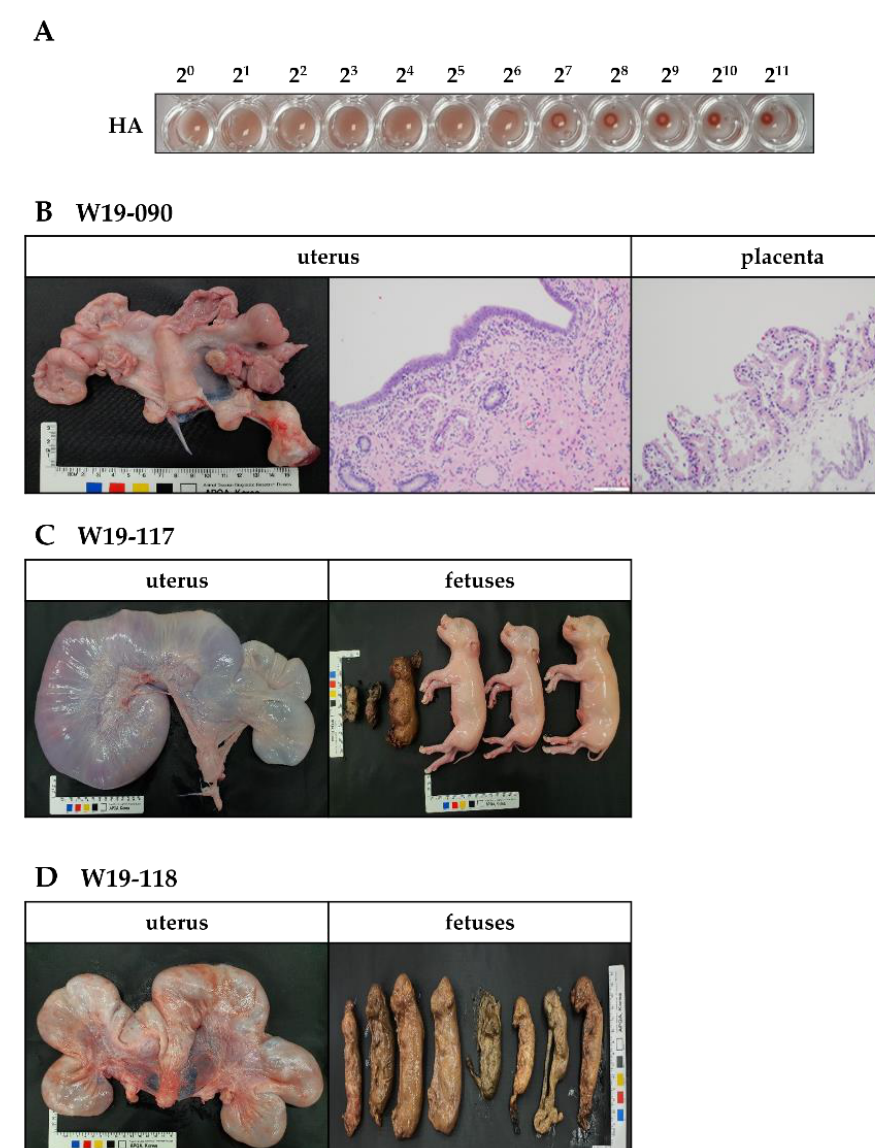
(Table 4). The HI units of vaccinated sows were 12–13 Log 2 at 0 DPC, and these values were non-mummified fetuses were sporadically positive for PPV1 (Table 2), those of mummi- maintained in the 12–14 Log 2 range until 49 DPC. In addition, the serum neutralization fied fetuses were all positive for PPV1 (data not shown). The HI units and neutralizing (SN) units of the vaccinated animals were 6–7 Log 2 at 0 DPC and were sustained above antibodies in sows challenged with PPV1-190313 were detected at 5 DPC. The HI units 8 Log 2 until 49 DPC. The HI unit of the unvaccinated PPV1-190313 challenge control was were maintained at >12 Log 2 throughout the experiment. The neutralizing antibody titers <2 Log 2 at 0 DPC but later rose to >13 Log 2 , where it was maintained for the duration of were also significantly elevated until 21 DPC and maintained at >10 Log 2 until the end of the experiment; in this sow, the SN units increased after 14 DPC and were maintained at the experiments (Supplementary Figure S2). over 9 Log 2 until 49 DPC (Supplementary Table S3).